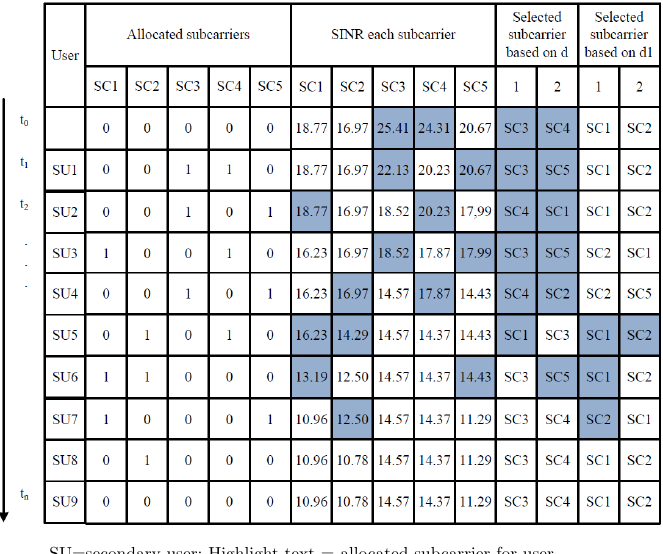
Figure 4. Timing diagram for the operational example of the ILRA-FM algorithm Type 1.